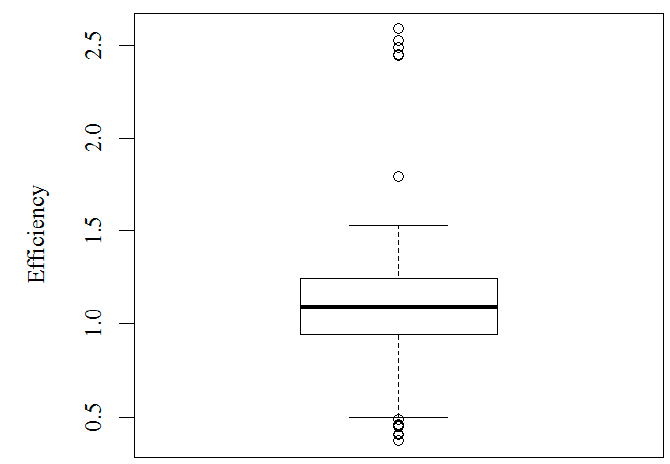
Figure 1. Pooled super-efficiency scores boxplot.